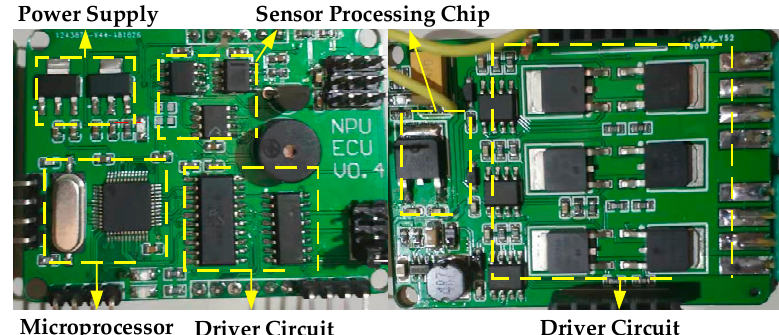
Figure 6. The printed circuit board (PCB) of the designed ECU.